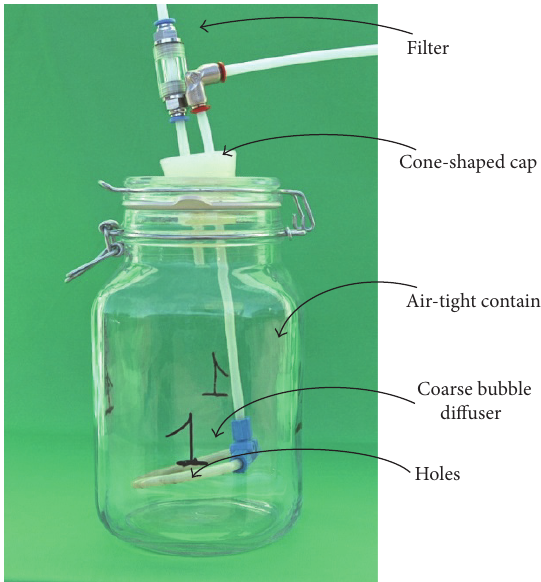
Figure 3: Prototyped arrangement for the